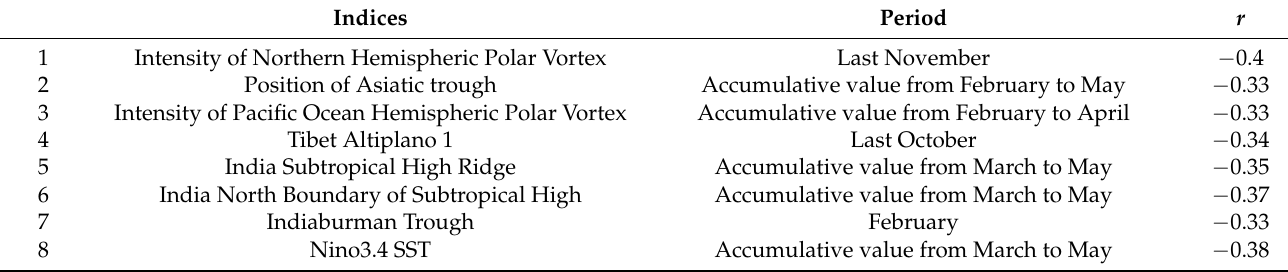
Table 1. Identified influencing factors of typhoon precipitation events.